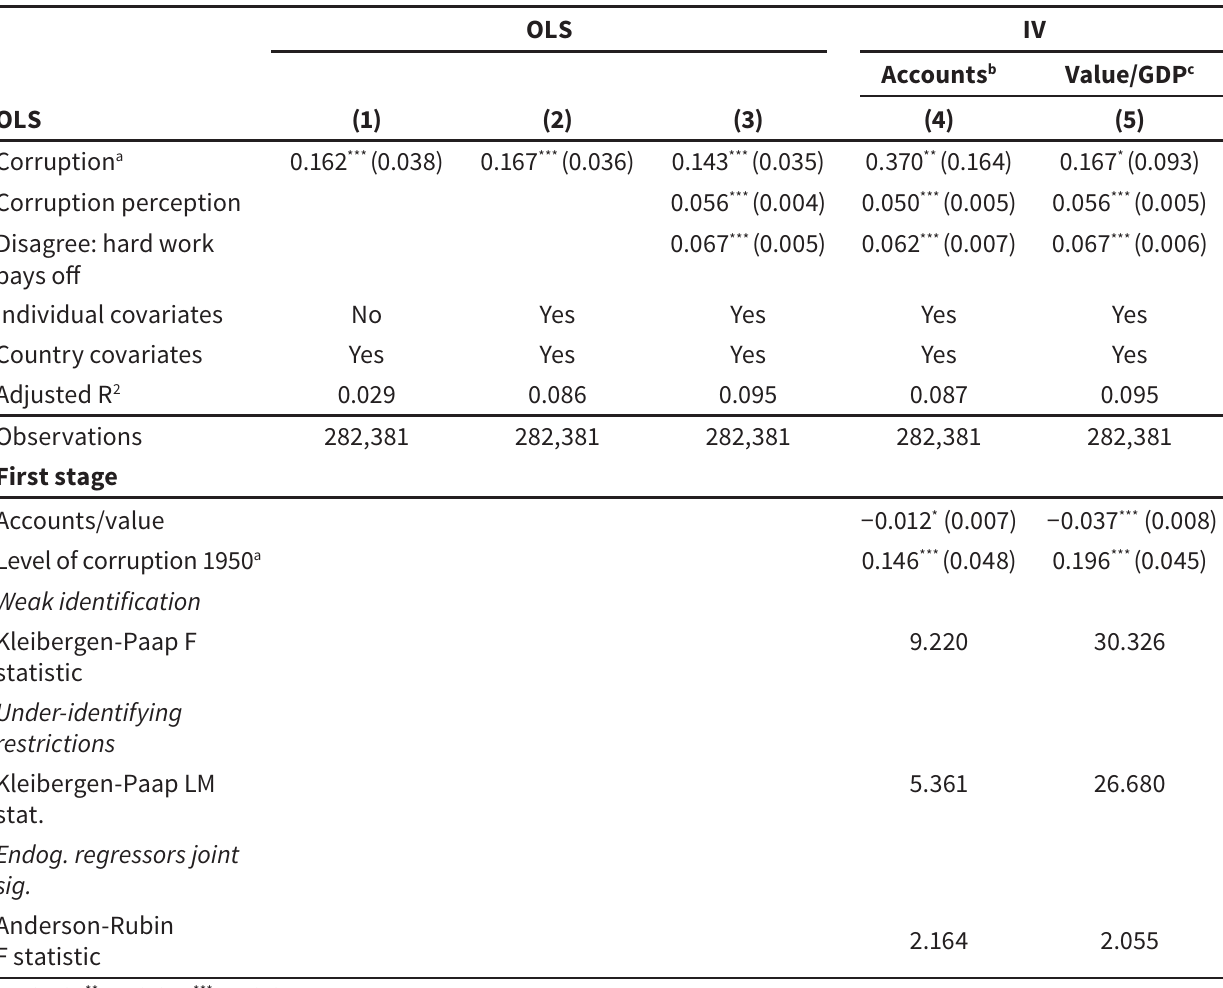
Effect of level of corruption on emigration aspirations OLS IV Accounts b Value/GDP